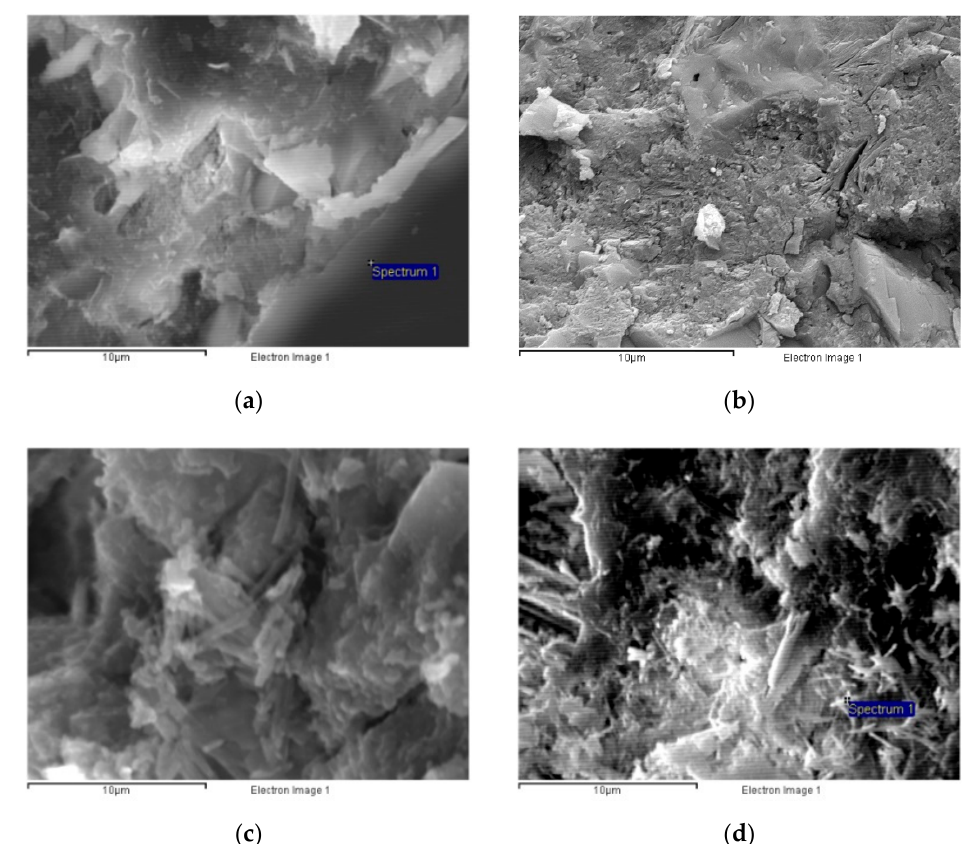
Figure 5. Micrographs (5000×) of concretes: ( a ) UH-0F-20; ( b ) C90; ( c ) C50; ( d ) C30. Composition